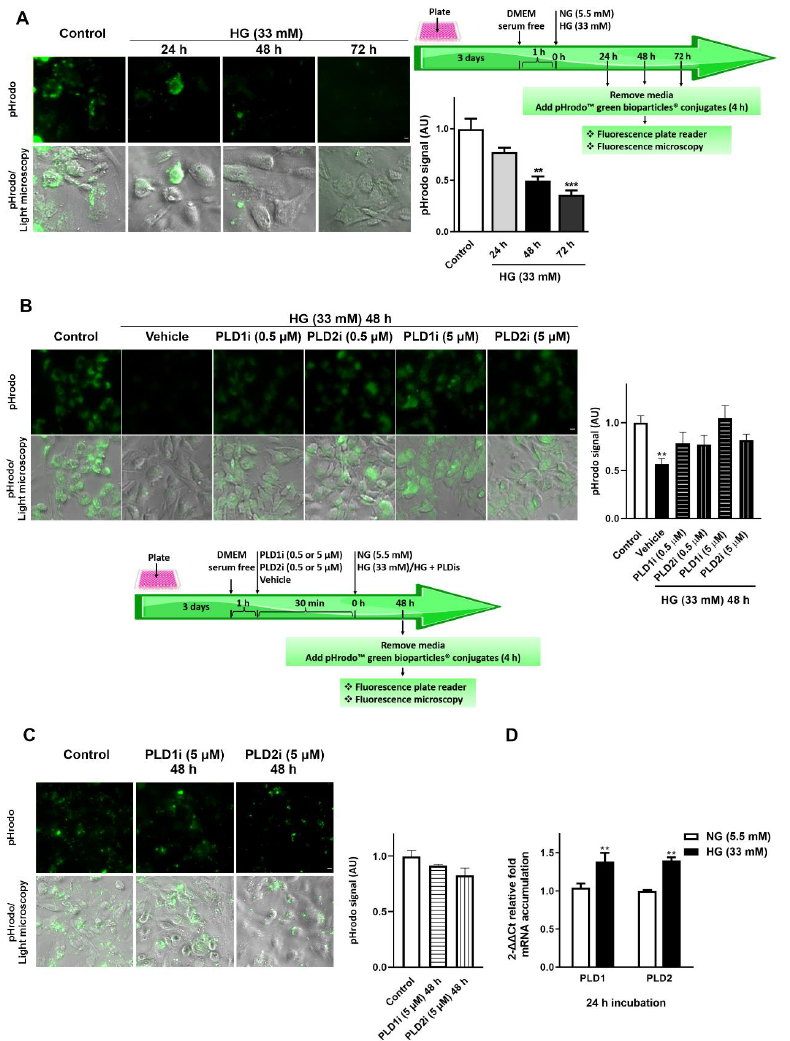
Figure 1. Non-specific phagocytosis in ARPE-19 cells exposed to inflammatory injury. ( A ) ARPE-19 cells were seeded in 96-well plates and exposed to high glucose concentration (HG, 33 mM) for 24, 48, or 72 h. ( B ) ARPE-19 cells were exposed to vehicle 0.025% DMSO (control condition), PLD1i (0.5 or 5 µ M) or PLD2i (0.5 or 5 µ M) for 30 min prior to cell exposure to 33 mM HG or to NG (control condition). PLD inhibitors were present during HG treatment. ( C ) ARPE-19 cells were exposed to vehicle 0.025% DMSO (control condition), PLD1i (5 µ M), or PLD2i (5 µ M) for 48 h in media containing normal glucose concentration (Control condition or NG, 5.5 mM). For A-C, non-specific phagocytosis was measured using pHrodo™ green bioparticles ® conjugates as described in the Materials and Methods section. Representative fluorescence images (Scale bar = 10 µ m) are shown; bar graphs show pHrodo fluorescence intensity expressed as arbitrary units (AU) with respect to control conditions. Significant differences with respect to each control condition are indicated with asterisks (*** p < 0.001; ** p < 0.01). ( D ) ARPE-19 cells were exposed to HG (33 mM) or NG (5.5 mM) for 24 h. qPCR assays for the quantification of PLD1 and PLD2 mRNA levels were performed as described in the Materials and Methods section. Results are expressed as 2 − ∆∆ Ct relative fold mRNA accumulation using GAPDH as internal reference gene. Significant differences with respect to NG are indicated with asterisks (** p <